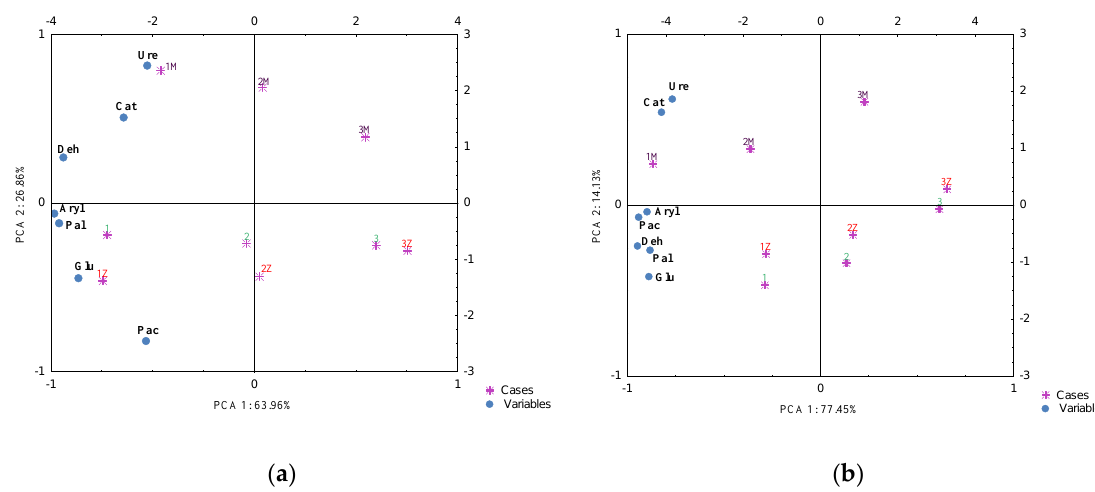
Figure 3. Activity of enzymes in soil contaminated with cobalt; ( a ) loamy sand; ( b ) sandy clay loam;